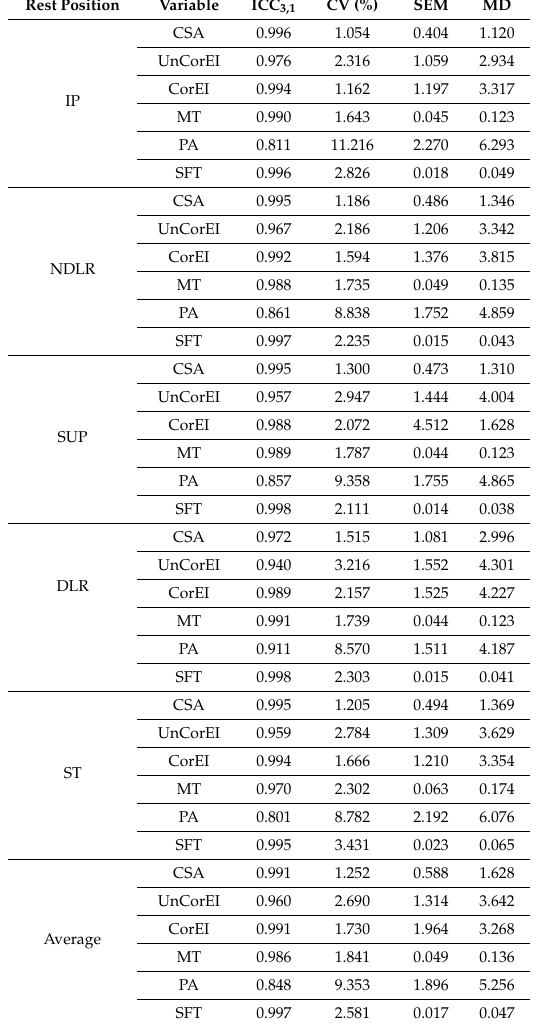
CSA: Cross-sectional area (cm 2 ); UnCorEI: Uncorrected echo intensity (AU); CorEI: Corrected echo intensity (AU); MT:Musclethickness(cm); PA:Pennationangle( ◦ ); SFT:Subcutaneousadiposetissuethickness(cm); IP:Assessments taken immediately post laying down in the non-dominant lateral recumbent position; NDLR: Assessments taken 15 min after laying down in the non-dominant lateral recumbent position; SUP: Assessments taken 15 min after laying down in the supine position; DLR: Assessments taken 15 min after laying down in the dominant lateral recumbent position; ST: Assessments taken 15 min after standing up; ICC: Intraclass correlation coe ffi cient; CV: Coe ffi cient of variation; SEM: Standard error of measurement; MD: Minimal di ff